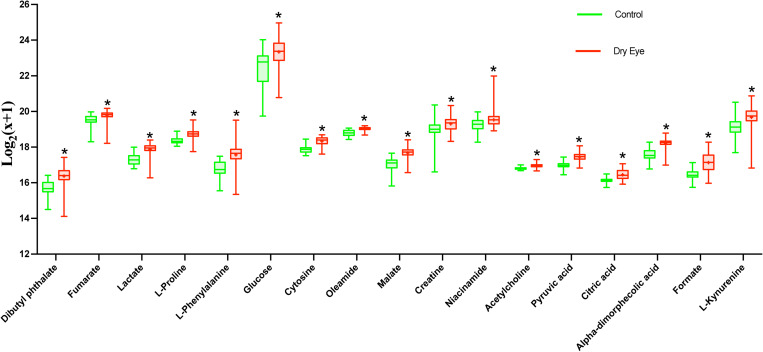
The 17 increasing metabolites presented by relative expression in the boxplot. *P < 0.05.